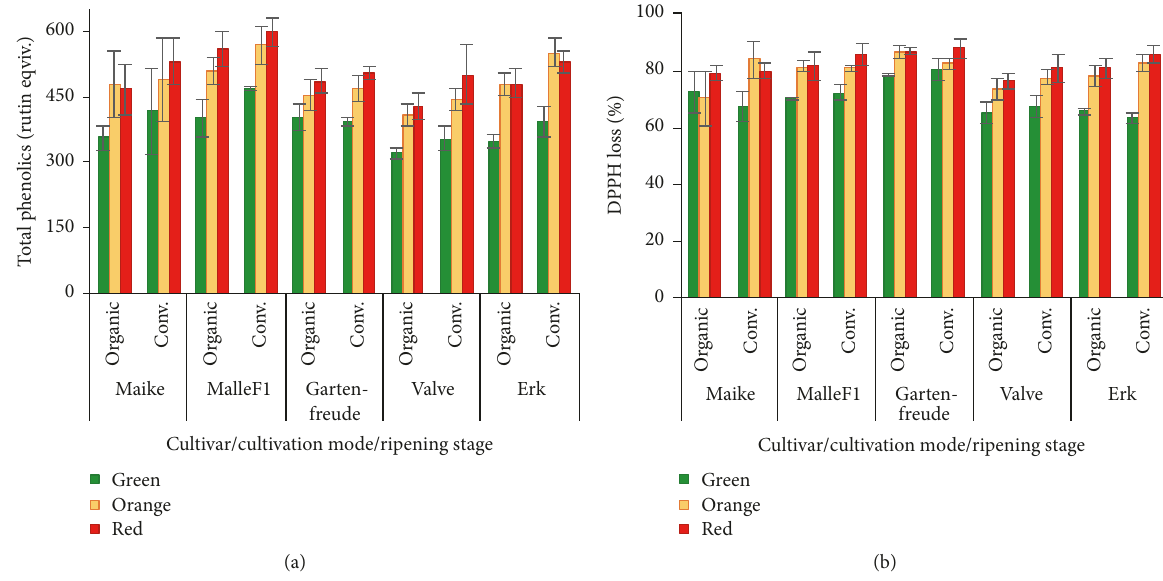
Figure 4: Total phenolics content by net area under curve (AUC) method (a) and free radical scavenging capacity method (b).